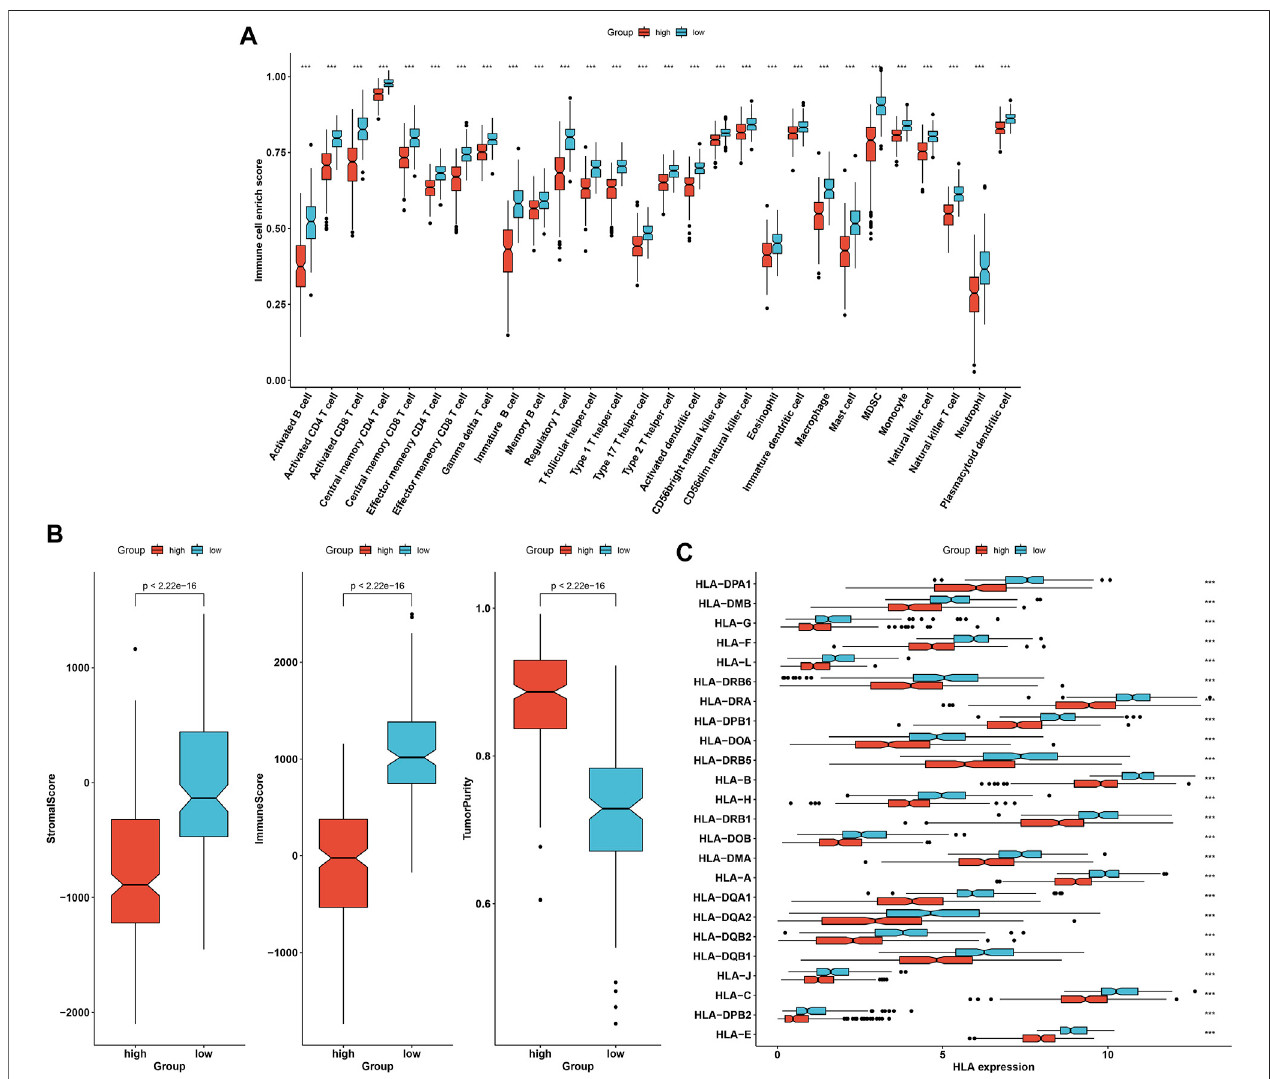
FIGURE5| Thisimmunescorepredictsimmunein fi ltratesandimmuneresponsesofOC. (A) Distributionofimmunein fi ltratesbetweenhighandlowimmunescore OC patients with ssGSEA algorithm. (B) The difference in stromal and immune score and tumor purity between high and low immune score groups. (C) Comparison of the expression of MHC molecules in two groups. *** p <